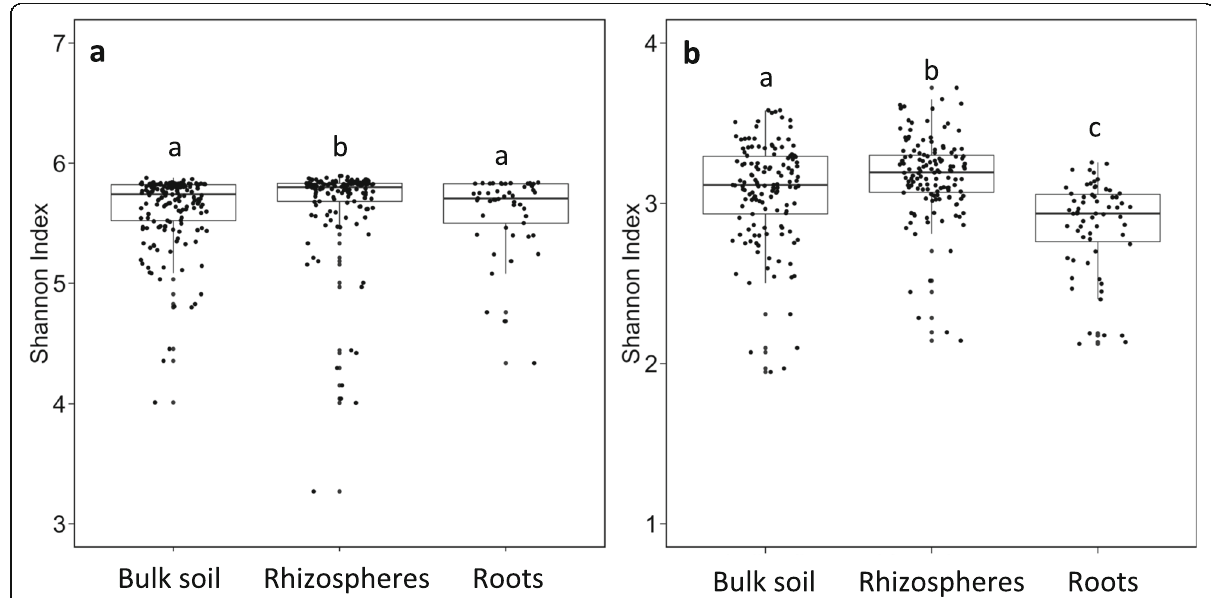
Fig. 8 Shannon diversity indices of bacterial ( a ) and fungal ( b ) communities found in bulk soil, the rhizosphere, and roots of all species studied. Different letters indicate significant differences after unbalanced ANOVA followed by Tukey ’ s multiple comparison